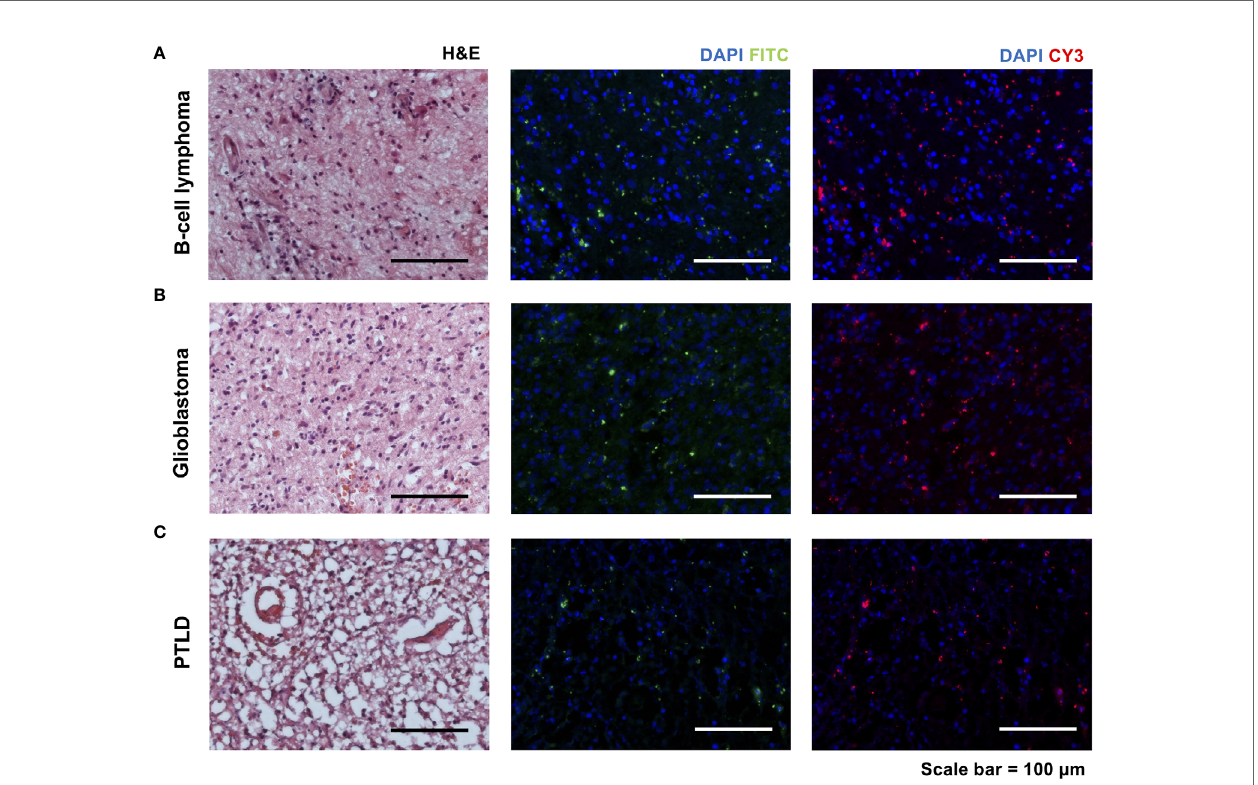
FIGURE 2 | Hematoxylin and eosin (H&E) staining of rapid sections in three different pathologies [ A , B-cell lymphoma, B , glioblastoma, and C , posttransplant lymphoproliferative disorder (PTLD)] with consecutive slides using FITC and CY3 fi lters of an immuno fl uorescence microscope. All samples showed signals in the FITC channel, and unexpectedly, also in the CY3 channel (scale bar = 100